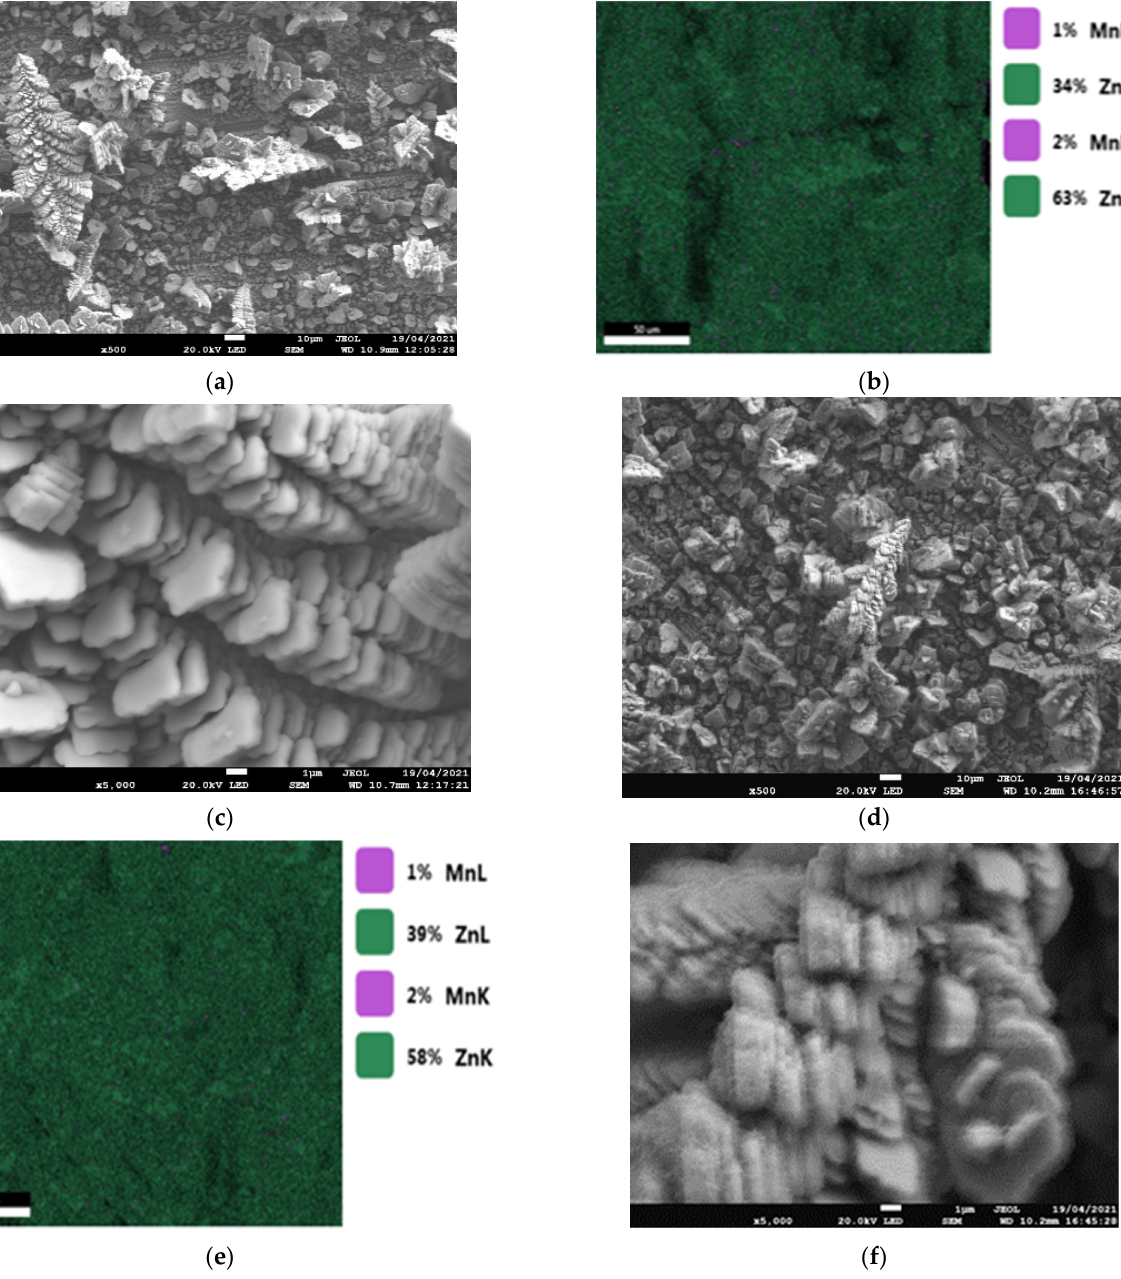
Figure 12. Morphologies of coatings elaborated for B = 0.3 T and for E = − 1.6 V/SCE, before immersion (( a ) imagex500, ( b ) mapping, and ( c ) imagex5000 and after immersion for 2 h in 35 g/L NaCl ( d ) imagex500, ( e ) mapping, and ( f ) imagex5000).